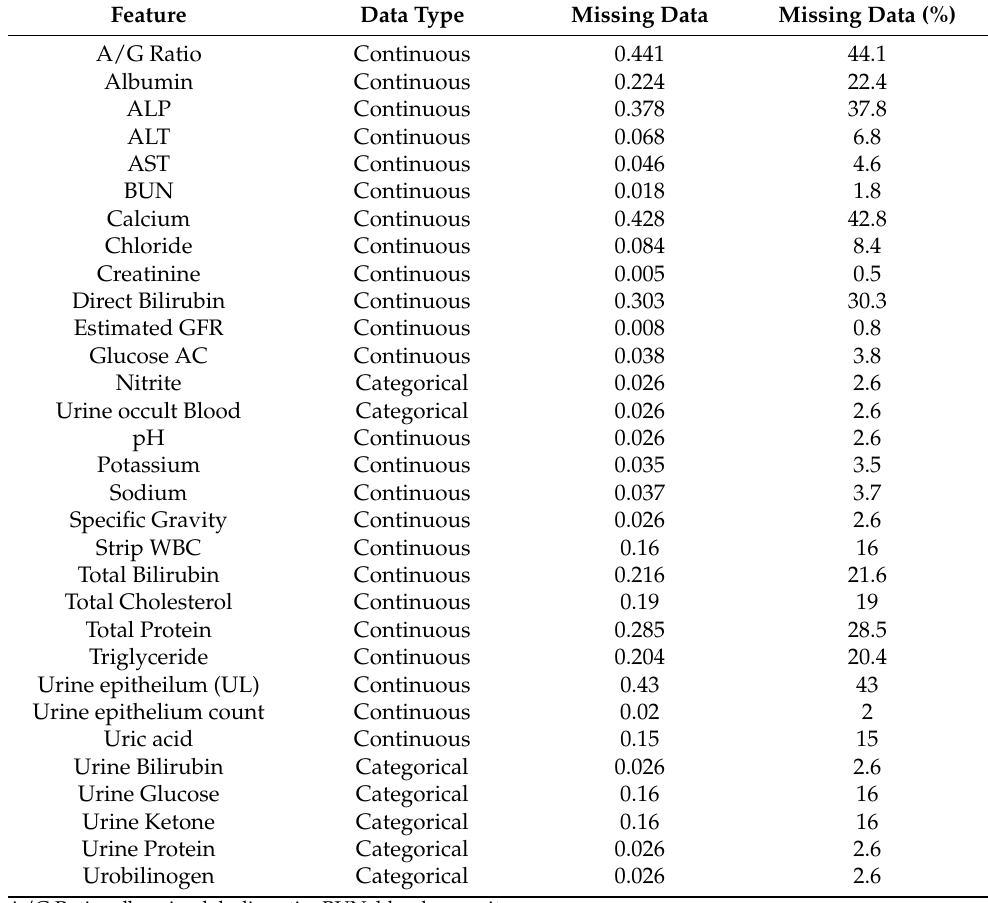
Table 1. The missing data rate in the clinical laboratory